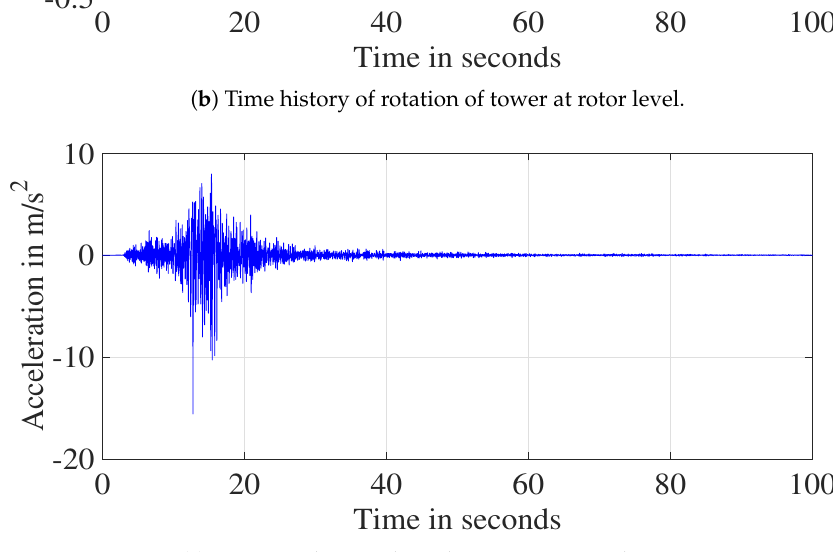
( c ) Horizontal ground acceleration response history. Figure 17. Seismic response of TLP floating wind turbine under horizontal ground